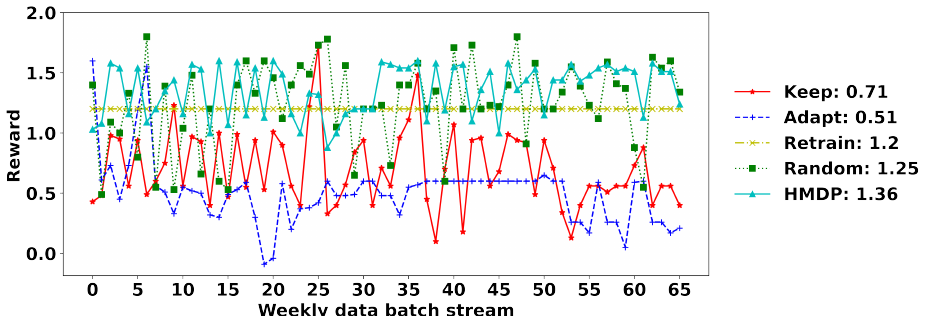
Figure 9. The average reward under different